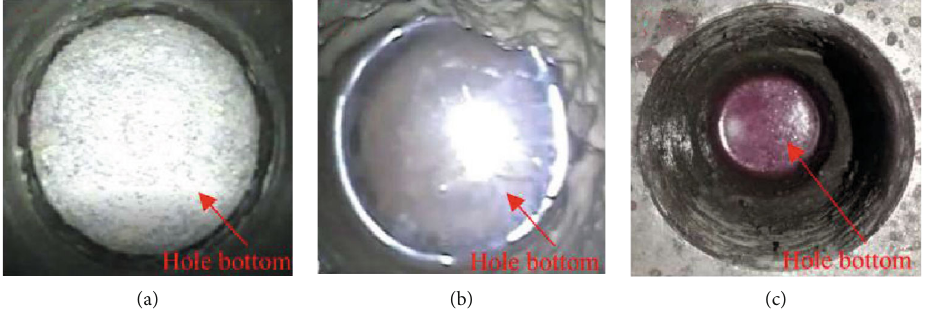
Figure 12: Water inrush process. (a) Crack initiation: dry hole bottom. (b) Crack propagation: leakage. (c) Crack penetration: water inrush (water turned red).